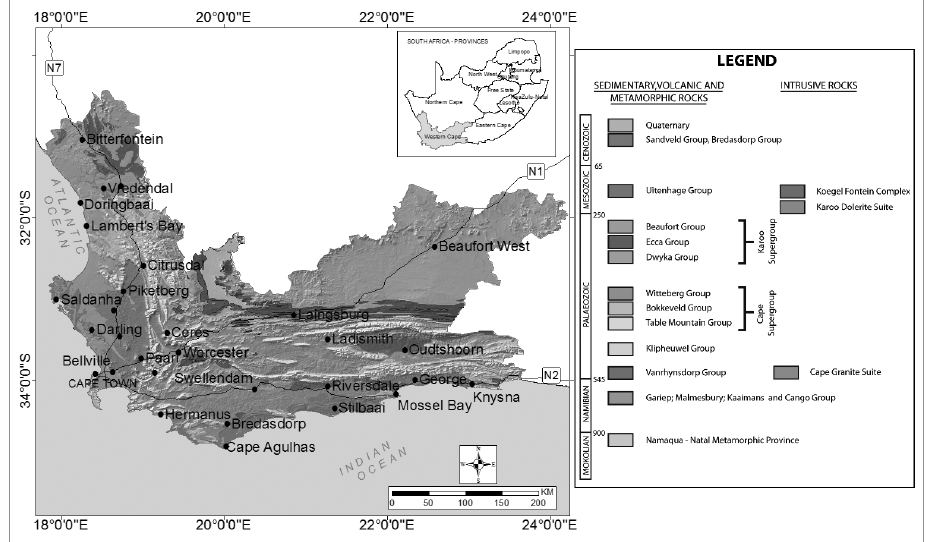
Figure 1: Geological map of the Western Cape Province. Mineral